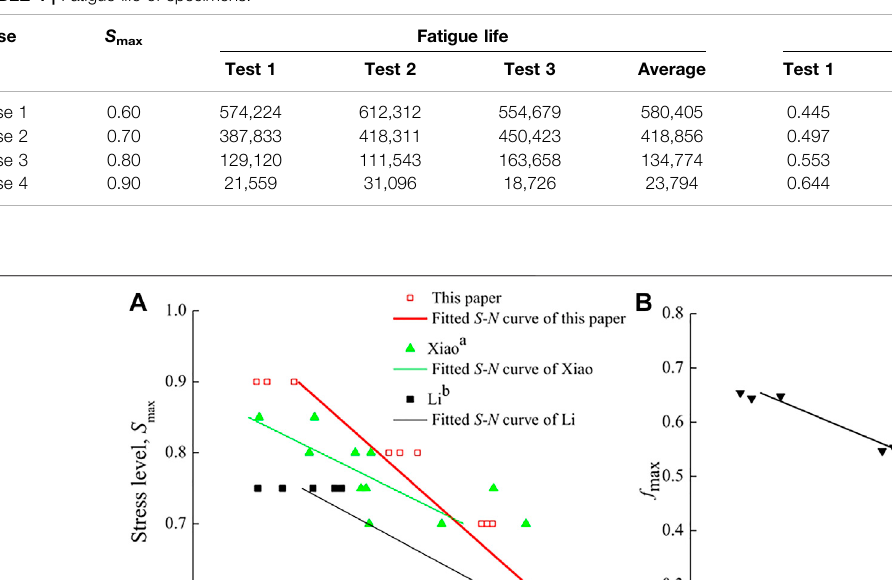
TABLE 4 | Fatigue life of specimens.